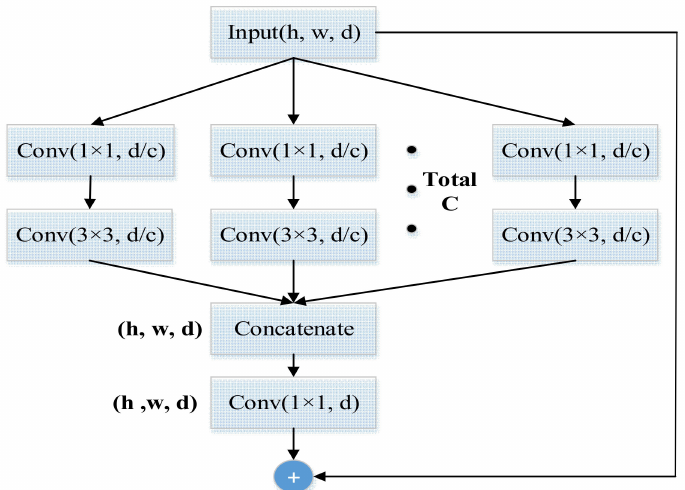
Figure 2. Grouped convolution.